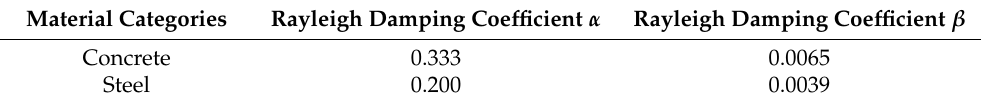
Table 5. Rayleigh damping coefficient of the composite beam with track.